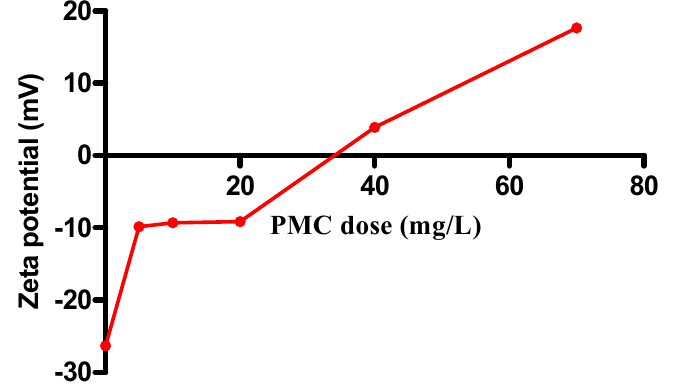
Figure 4. Effect of PMC-based coagulant dose (0, 5, 10, 20, 40, and 70 mg/L) on Zeta potential.